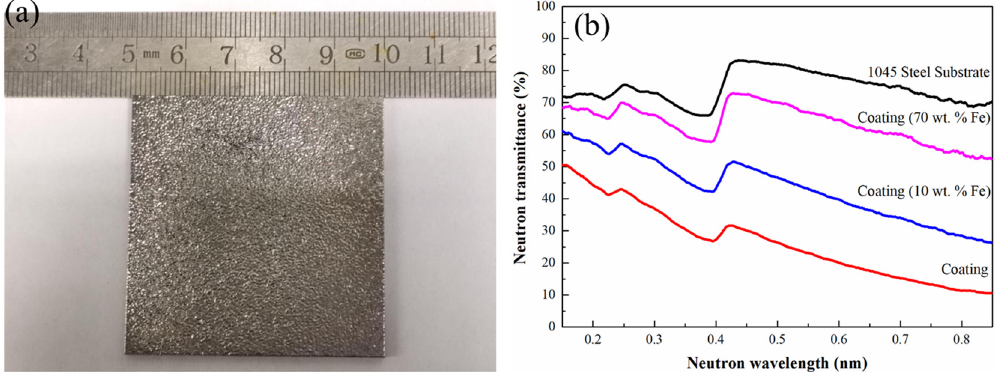
Figure 10. ( a ) Appearance of typical laser-cladded samples for neutron shield testing. ( b ) Neutron transmittance at different wavelengths for the coatings with the different additions of Fe powder. The background data for the 1045 steel substrate are also shown for comparation.